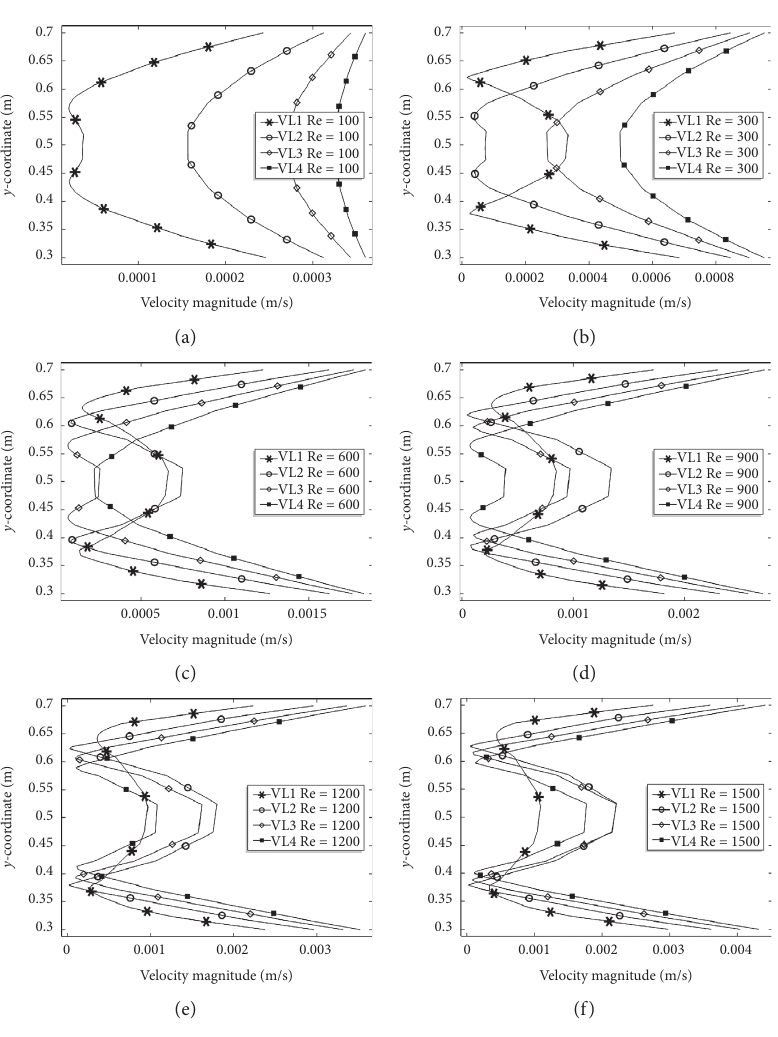
Figure 9: View of the velocity field along vertical lines.